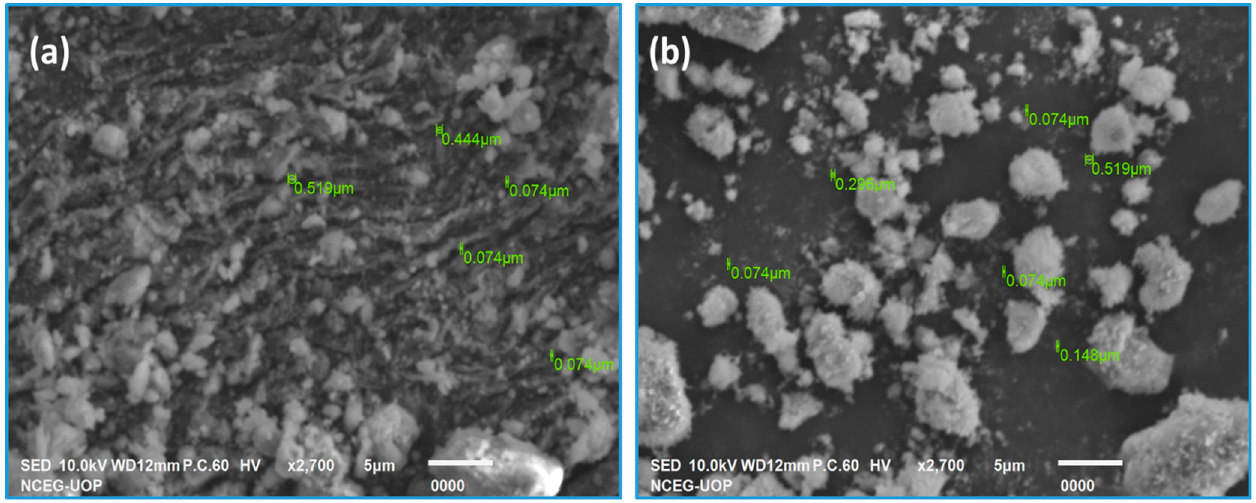
Figure 4. ( a ) SEM image of nickel magnetite and ( b ) CS-NM biocomposite.